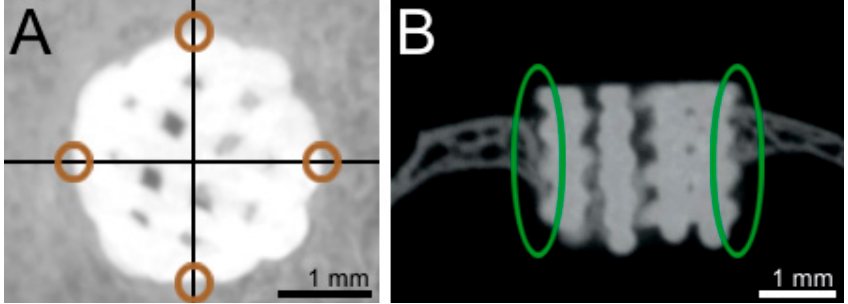
Figure 2. Transverse ( A ) and coronal ( B ) µCT cuts of bone defect and scaffold. Bone thickness (green circles) was measured at four distinct locations (brown circles) per defect.